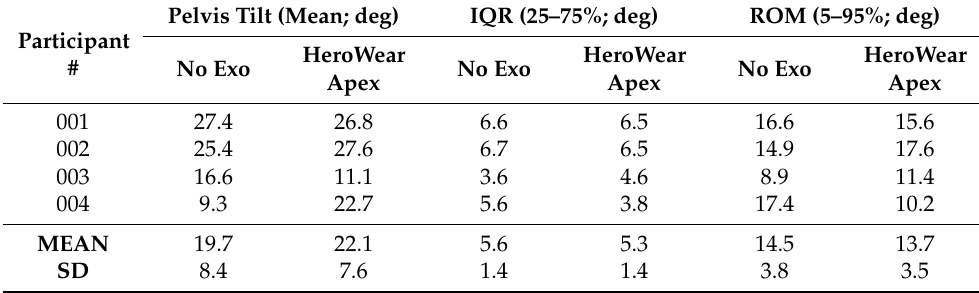
Table 4. Pelvis tilt (deg) for pushing the loaded gondola at level ground.